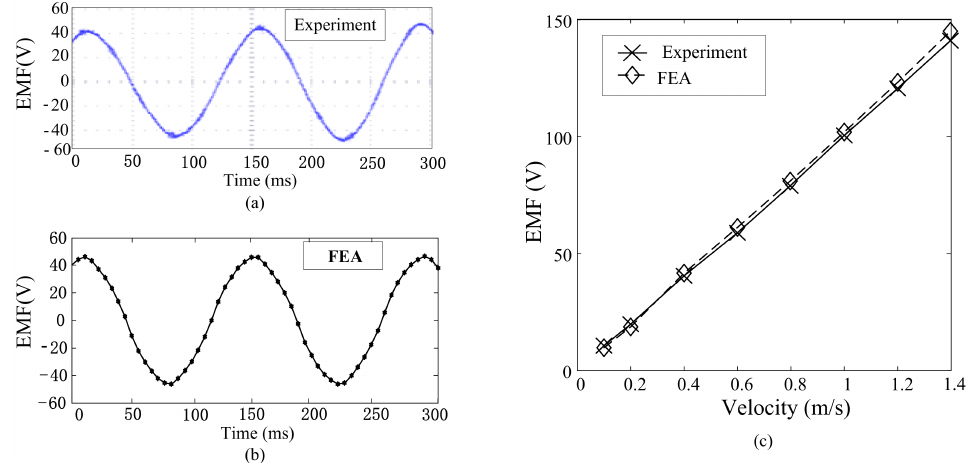
Figure 14. EMF waveforms at constant and varying velocities: ( a ) through experiment at velocity of